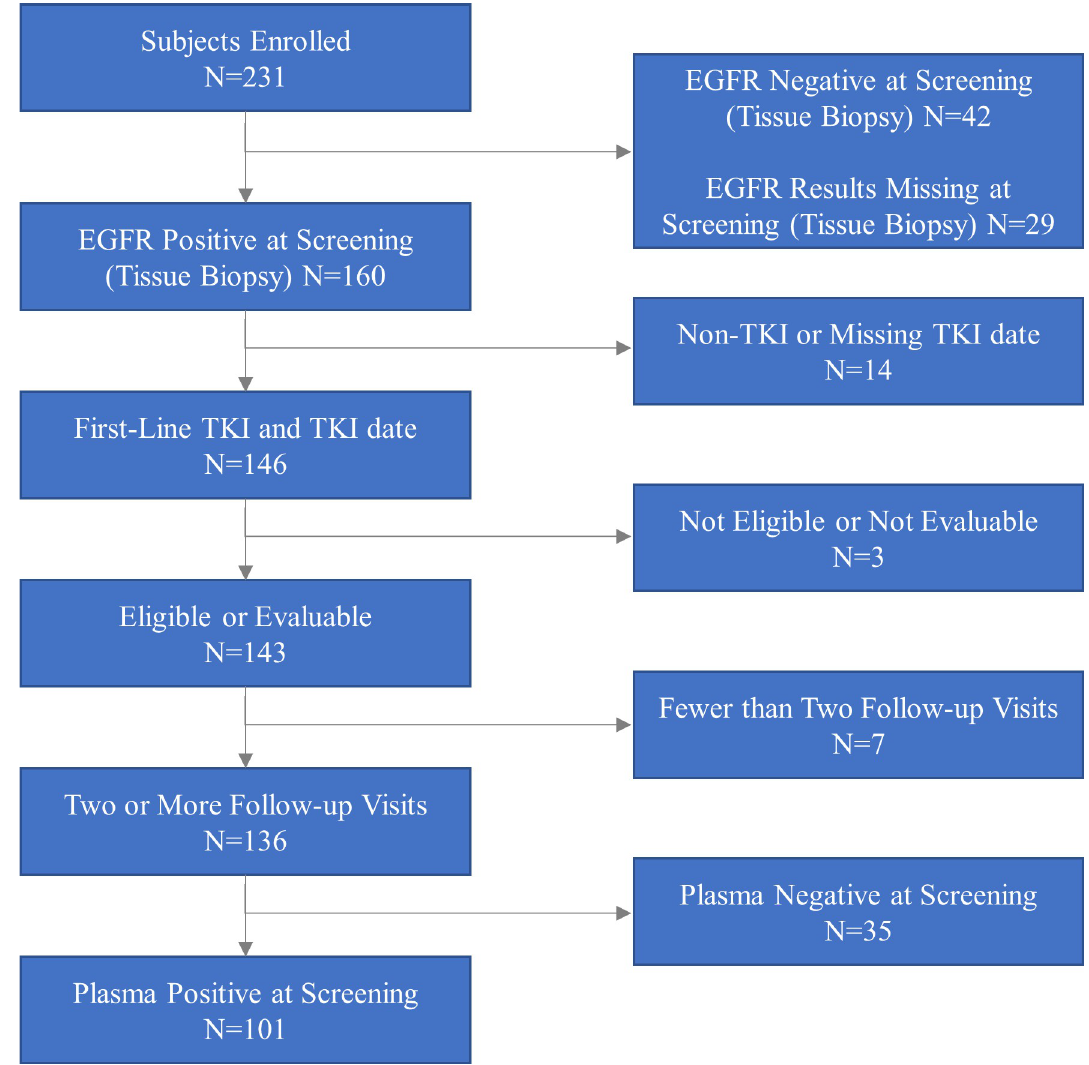
Fig 1. Patient flow diagram. “Non TKI” means that patients were not treated with anti-EGFR TKIs due to clinical reasons. “Missing TKI date”–we excluded patients with the drug administration date missing or not available in the database. “First line TKI and TKI date” means EGFR TKI as first-line treatment was given and date of first-line TKI was available. “Eligible or evaluable”–one patient withdrew consent during the